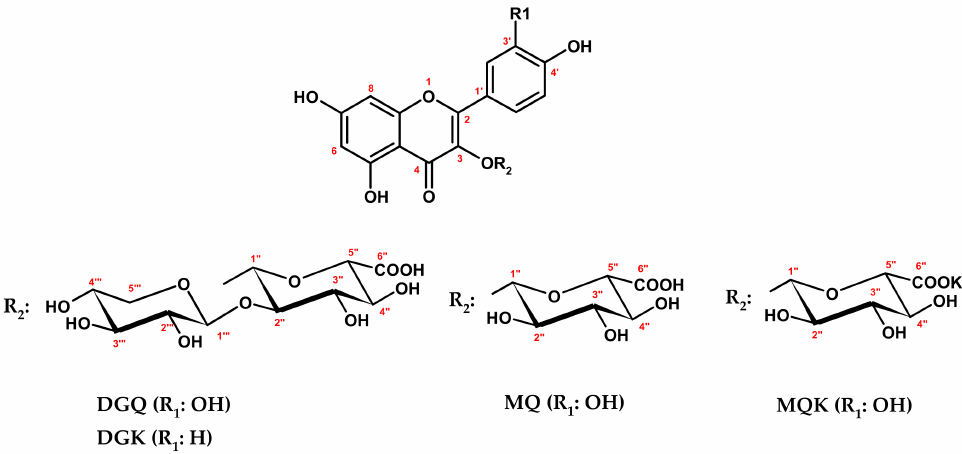
Figure 3. Structures of the isolated flavonoid compounds DGQ (wintergreenoside A), DGK (win- tergreenoside B), MQ (miquelianin), and MQK (miquelianin potassium salt). Atom numbering in